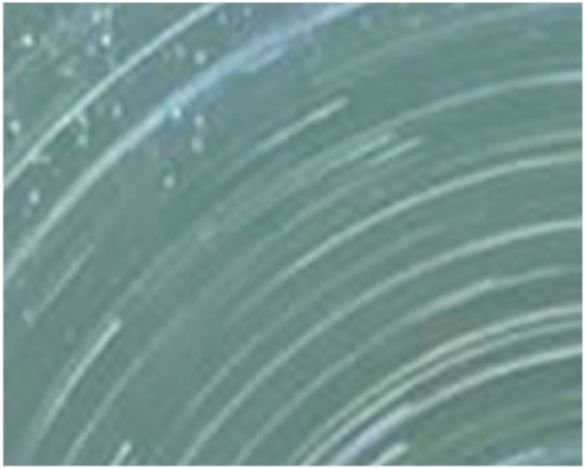
Figure 11. Mirror blank surface under white light.